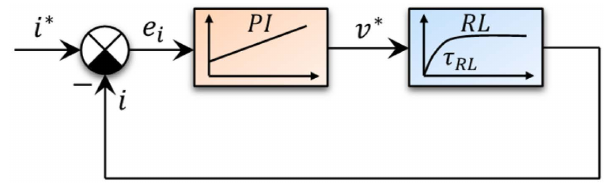
Figure 5. Block diagram of the simplified current loop scheme.